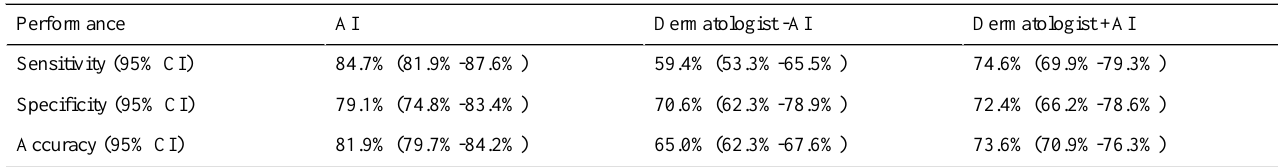
Table 1. Overall mean performance of dermatologists without artificial intelligence (AI) support (-AI) compared to that of dermatologists with AI support (+AI) and AI on its own. Performance is split into 3 categories, that is, sensitivity, specificity, and accuracy.